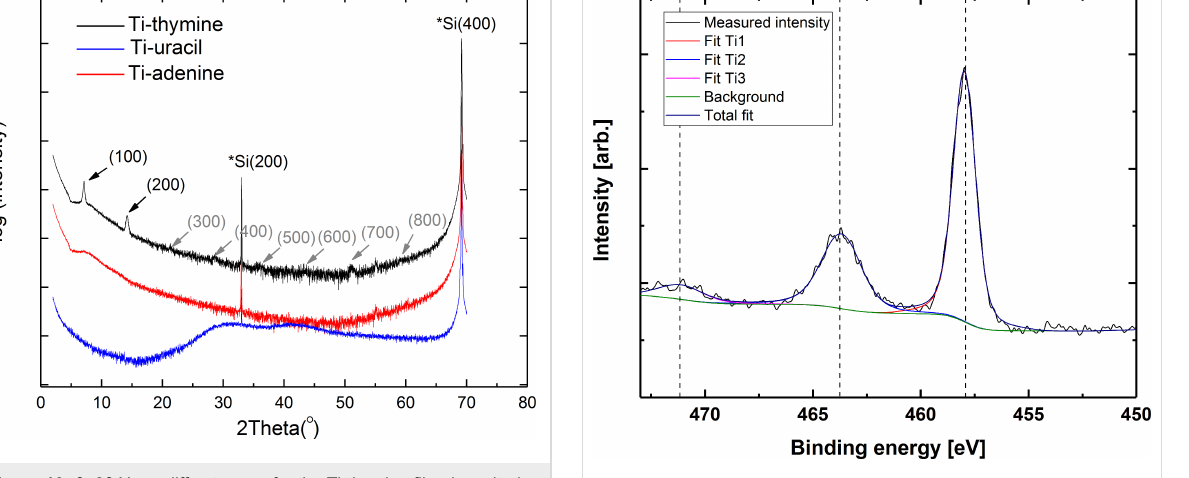
intensity is rather weak (marked with grey arrow). We were not able to identify any additional reflections and we were also unable to match those found with any known materials contain- ing thymine or titanium oxide. Overall, a more in-depth investi- gation of the structure of the Ti-thymine films should be per- formed. No sign of crystallinity was observed for Ti-adenine and Ti-uracil by AFM or XRD.